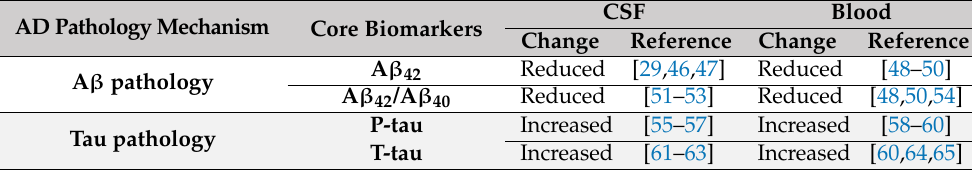
Table 5. Summary of core AD fluid biomarkers in CSF and